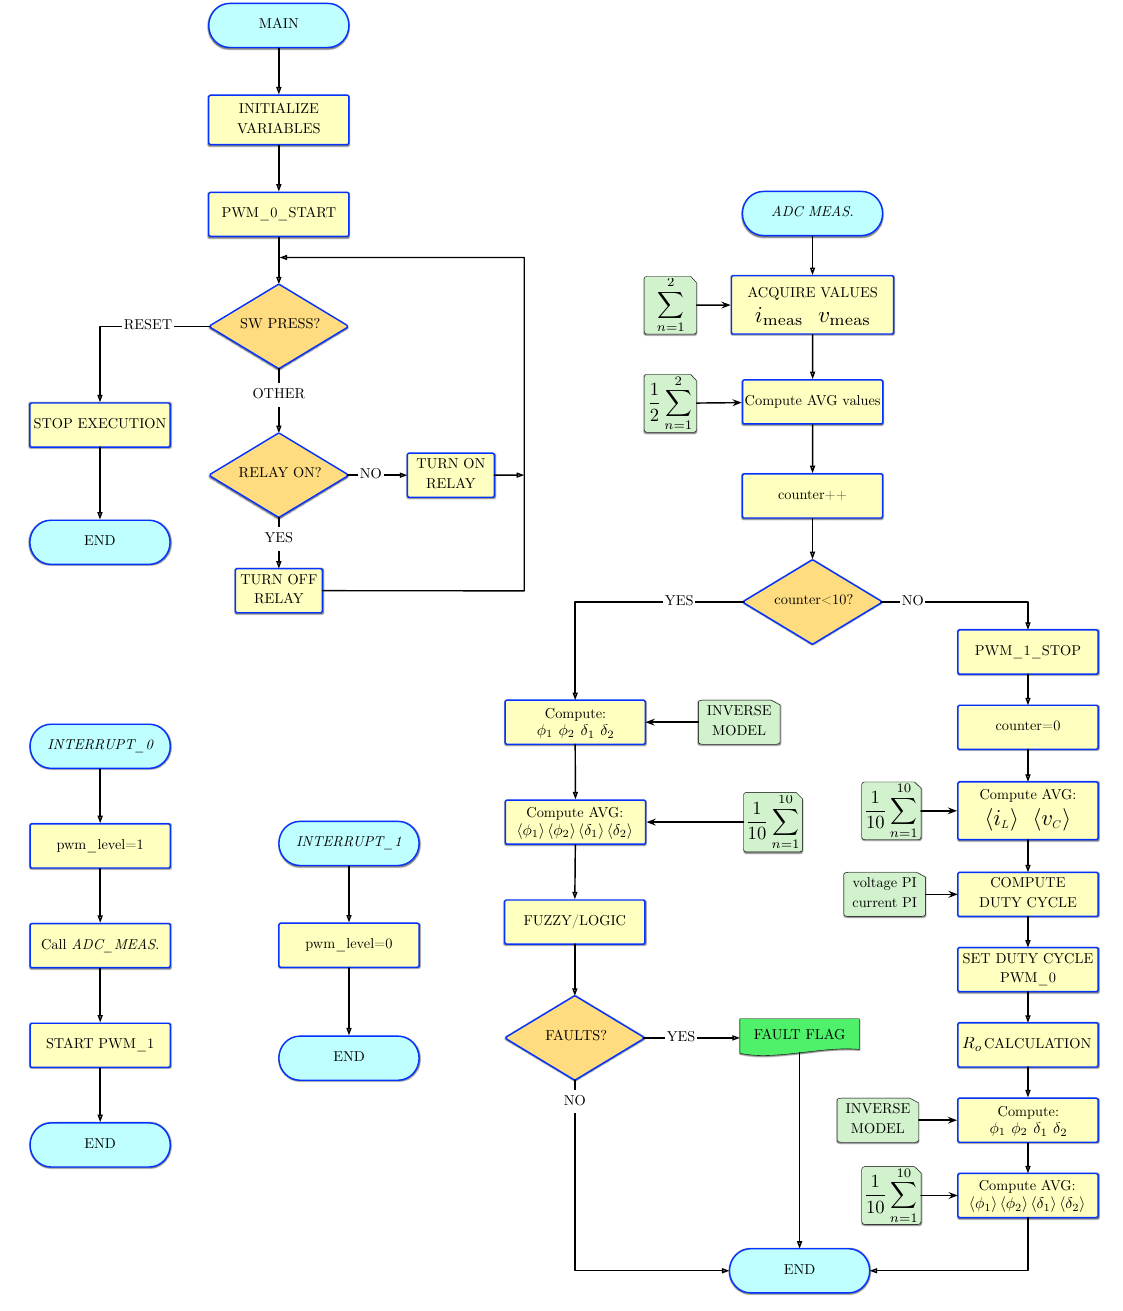
Figure 14. Software execution